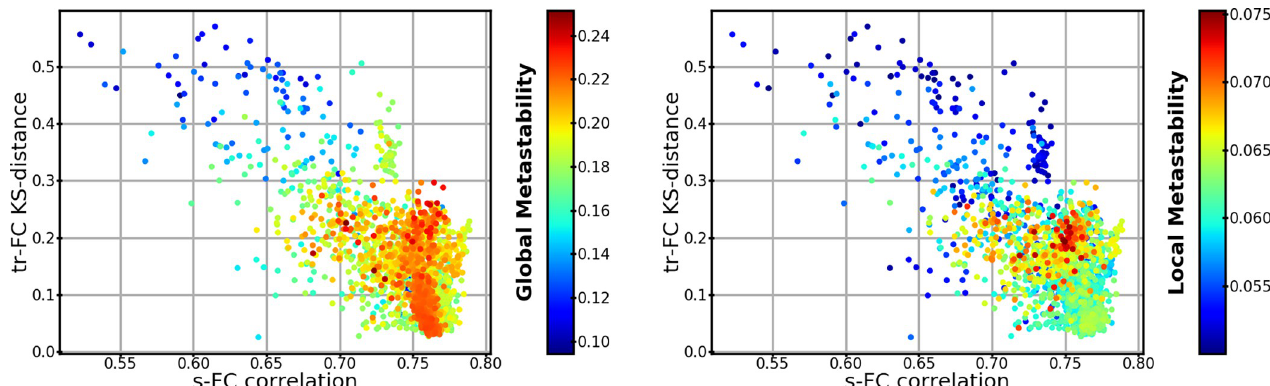
Fig 5. Global and local metastability of heterogeneous ensembles as a function of trFC and sFC similarity between 300-second simulations and MEG for the best 2000 simulations. Each dot represents one simulation similar to Fig 3. (Left panel) Dots are colored by their global metastability. (Right panel) Dots are colored by their local